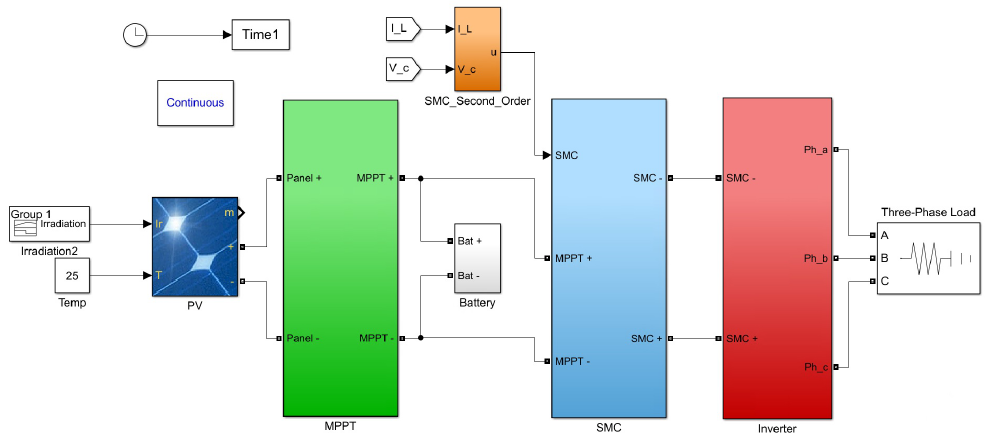
Figure 10. Overall Design.